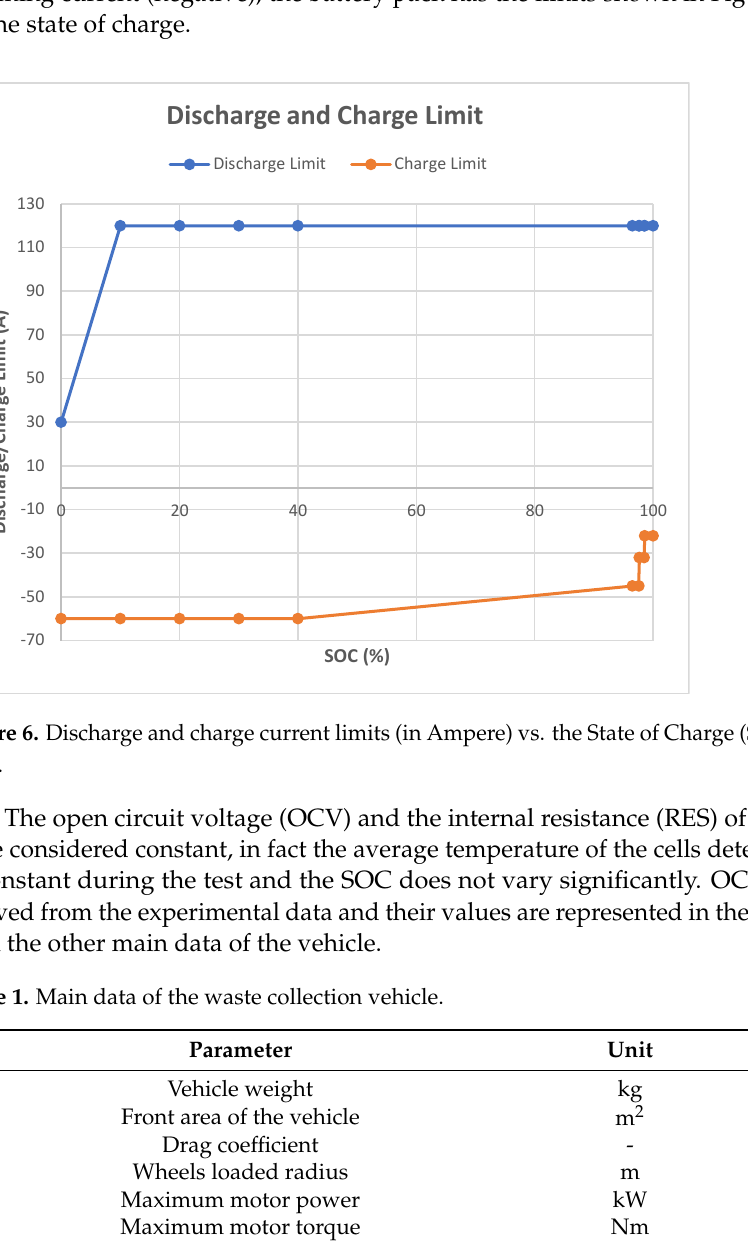
Figure 5. Peak torque and the continuous torque of the traction motor vs. the speed of rotation of the electric motor itself (in RPM).